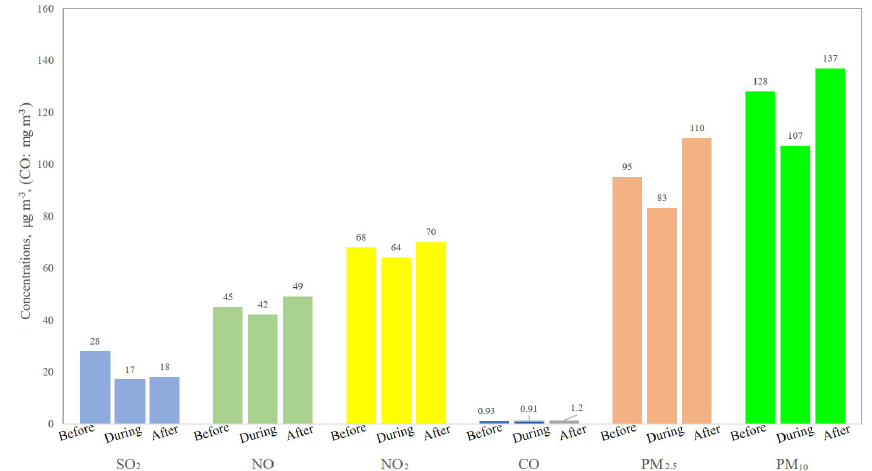
Figure 9. Comparison between air pollutant concentrations at Shanxi station before, during, and after the campaign under stagnant meteoro- logical